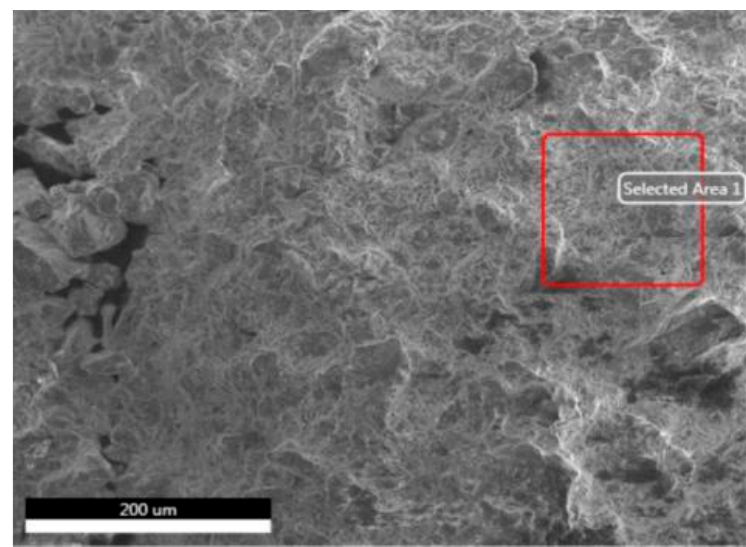
Figure 11. D-0 selection of energy spectrum region of soil sample.